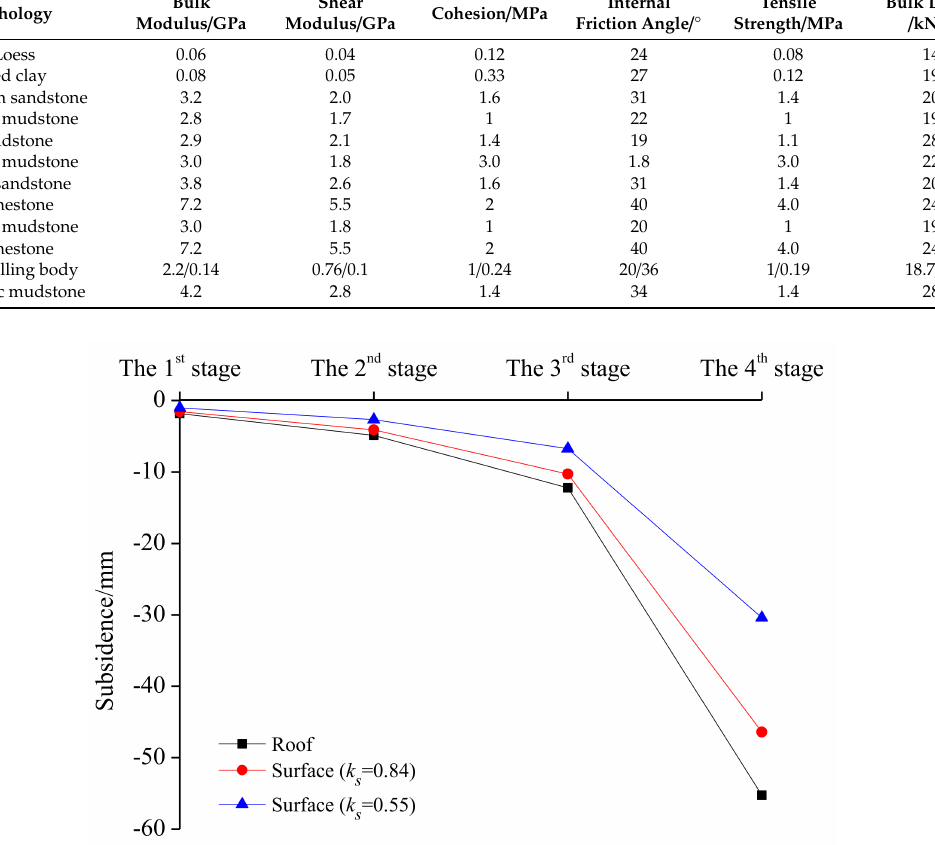
Figure 10. Subsidence of roof and ground in every